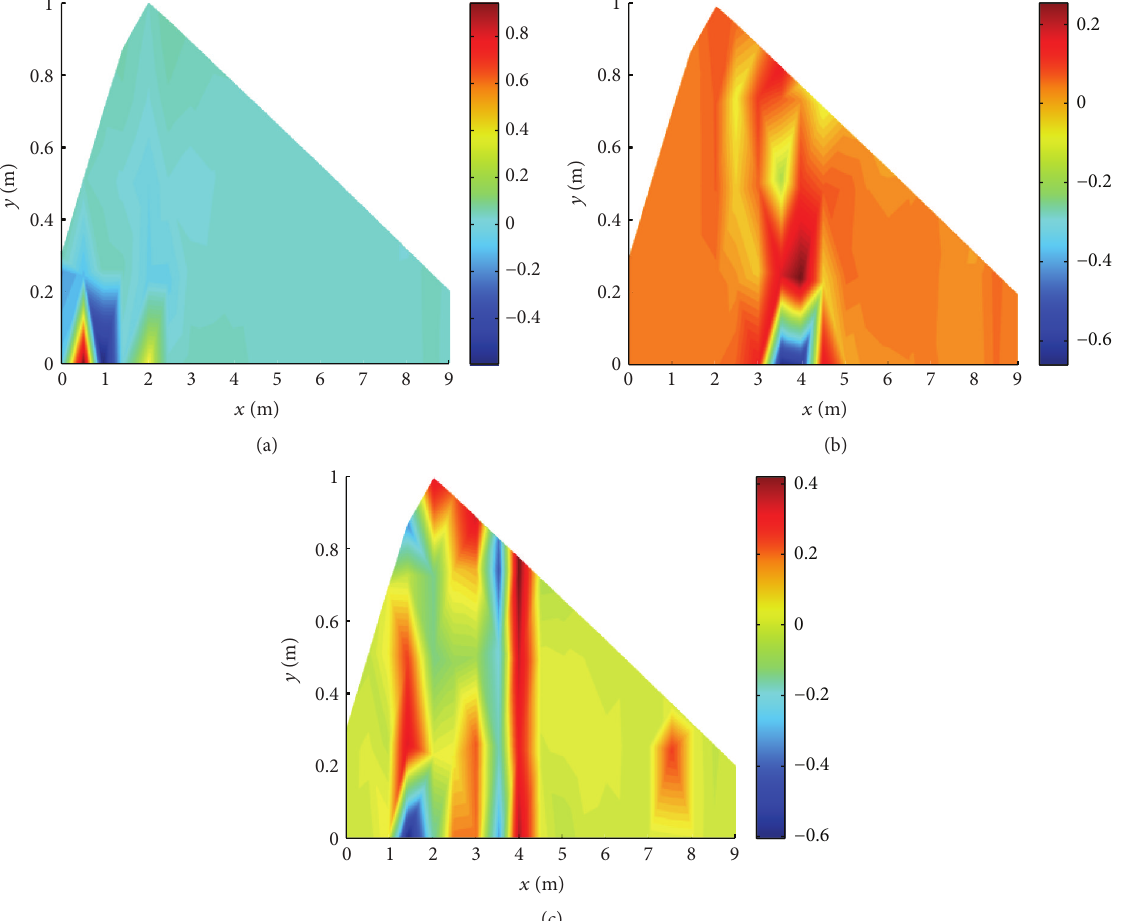
Figure 9: Damage maps 𝐽 for different damage locations: (a) location 2, (b) location 3, and (c) location 4.